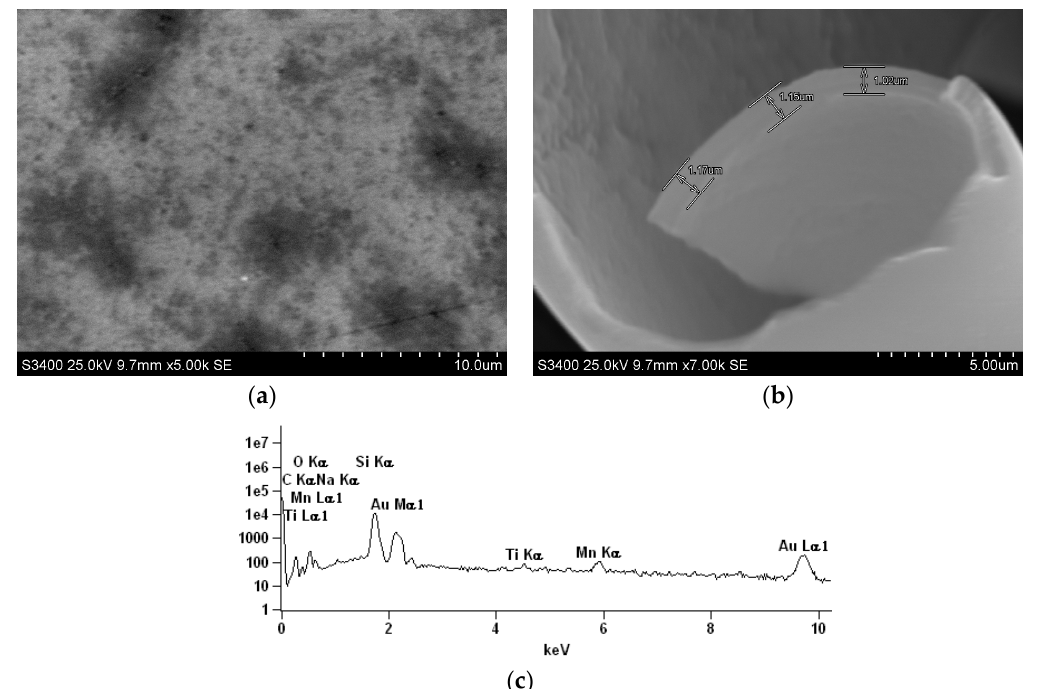
Figure 4. SEM image of the front view of the deposited MnOx-LS film ( a ) and the view on the part of the film that start to detach from the electrode surface with measurements of the film thickness ( b ). Energy dispersive spectroscopy (EDS) spectrum of the deposited film ( c ). Table 1. The results of the EDS elemental analysis of the MnO x -LS film.